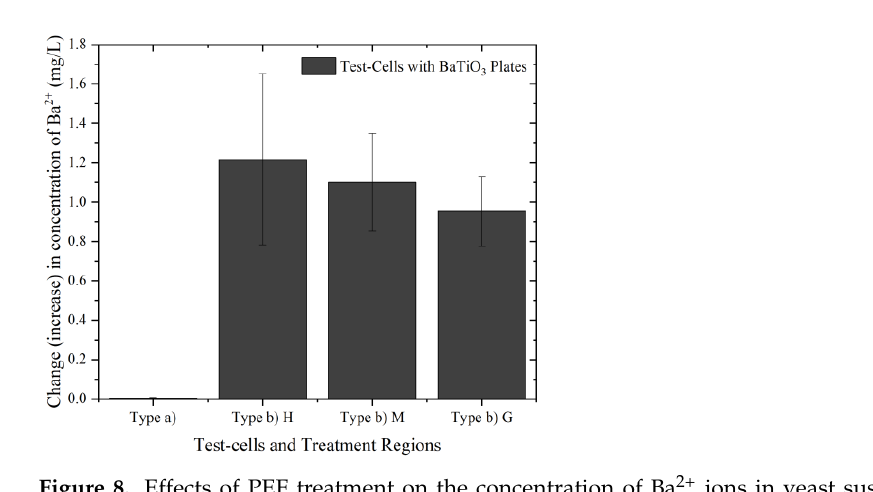
Figure 8. Effects of PEF treatment on the concentration of Ba 2+ ions in yeast suspension using different types of chambers. Error bars show standard deviation (n = 3). Table 2. Statistical analysis of the experimental results of iron ions concentration